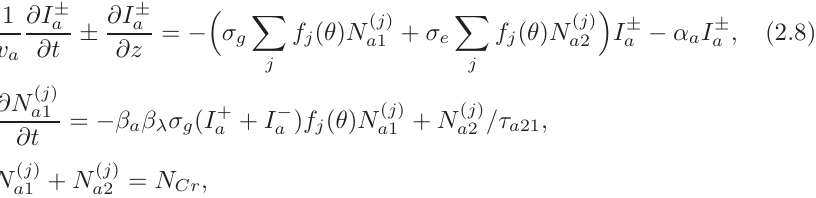
Figure 3. A scheme of energy levels and transitions in Cr:YAG